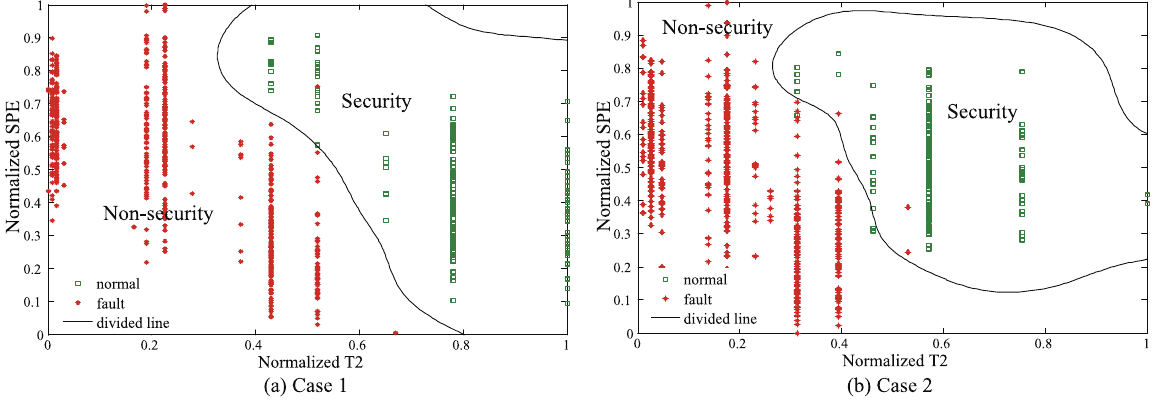
Fig. 5. Safety region estimation results for rolling bearing operational